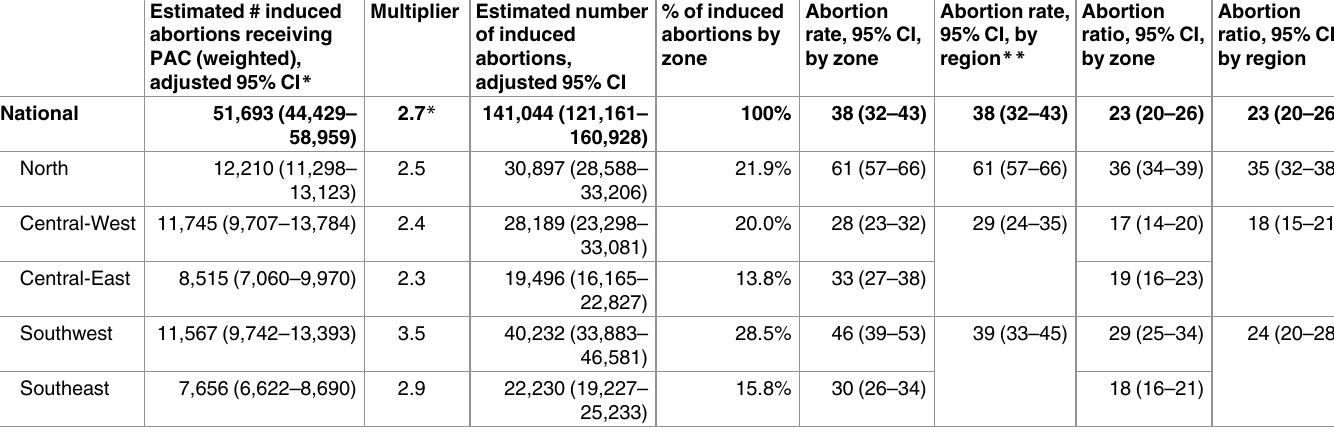
Table 4. Estimated distribution of induced abortions receiving post-abortion care, and estimatedpercentageof all induced abortions, Knowledge- able Informant Survey, Malawi 2015.